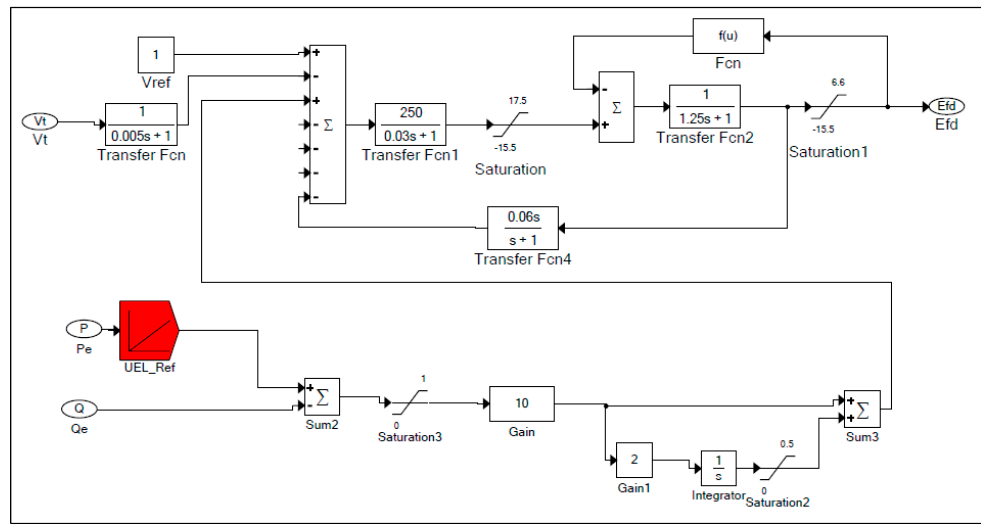
Figure 12. UEL (Under Excitation Limit) modeling.